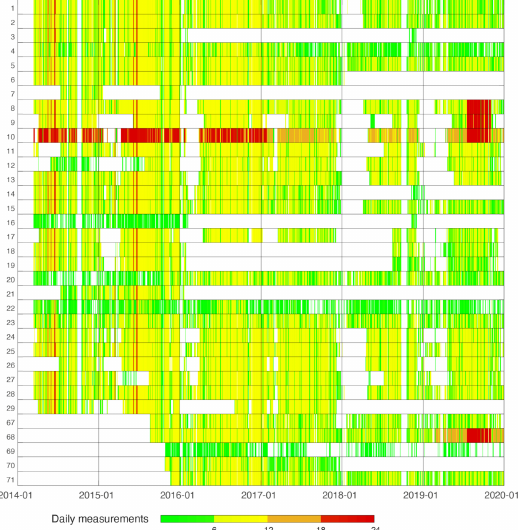
Figure 5. Availability of TPS1 (Leica TCP 1201) measurements over the monitoring period. The target ID is shown in the y -axis (for the location of targets see Figure 1), while the colormap shows the amount of daily measurement cycles performed.